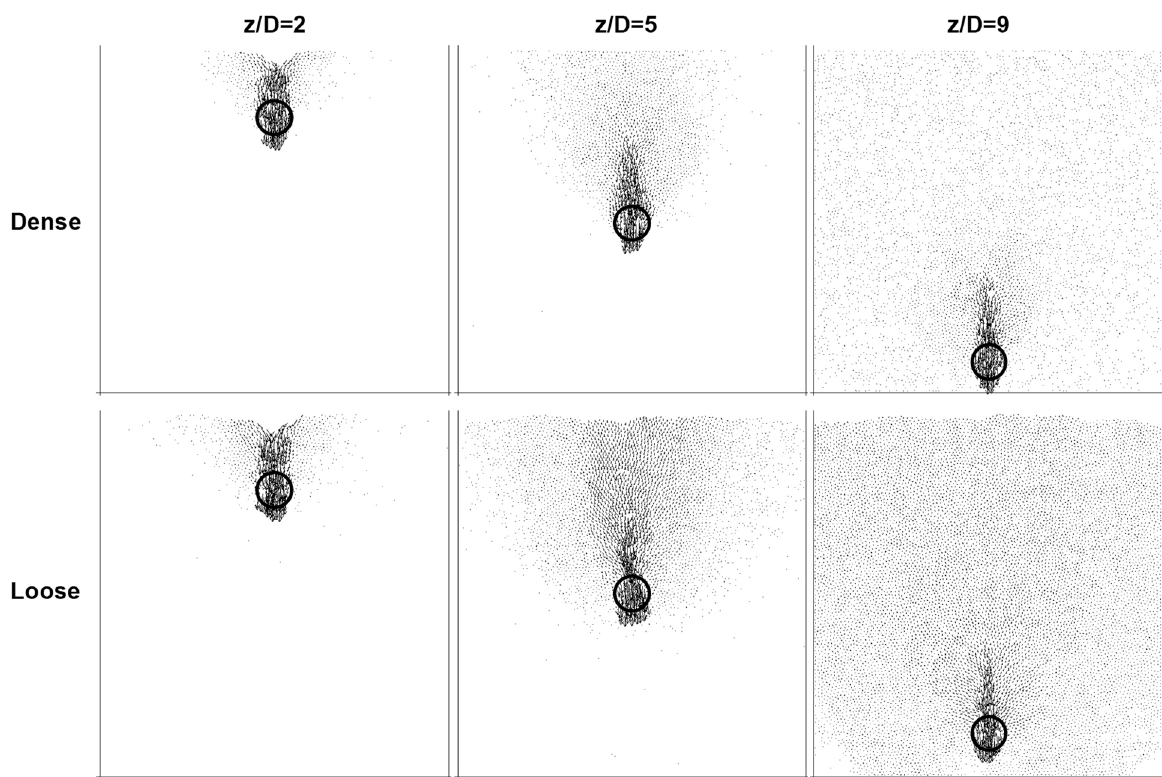
Figure 3. Granular flow during cavity refill—displacement vectors. Vector magnitudes are equally scaled for all cases. The black circles indicate the original location and size of the dissolving inclusions. Note: hindered rotation HR = 40%.